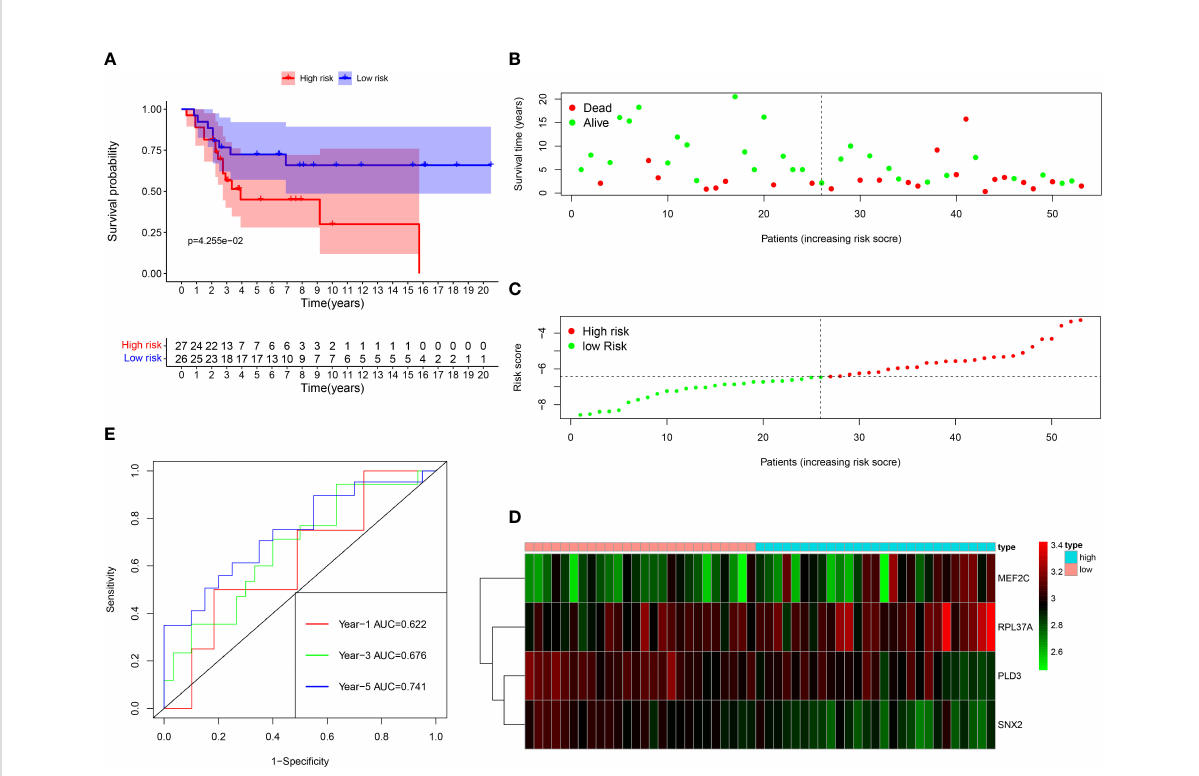
FIGURE 5 Survival analysis results of a risk ‐ scoring model for GEO osteosarcoma patients. (A) Kaplan – Meier survival analysis of GEO osteosarcoma patients in high ‐ risk and low ‐ risk groups. (B) The overall survival rate and the survival status of GEO osteosarcoma patients. (C) The distribution of risk scores for each patient. (D) The expression levels of these 4 B cell marker genes in the high ‐ risk and low ‐ risk groups. The green color represents low expression, while the red color represents high expression. (E) ROC curve analysis of the risk-scoring model ’ s 1-year, 3 ‐ year, and 5 ‐ year OS. OS, overall survival, ROC, receiver operating